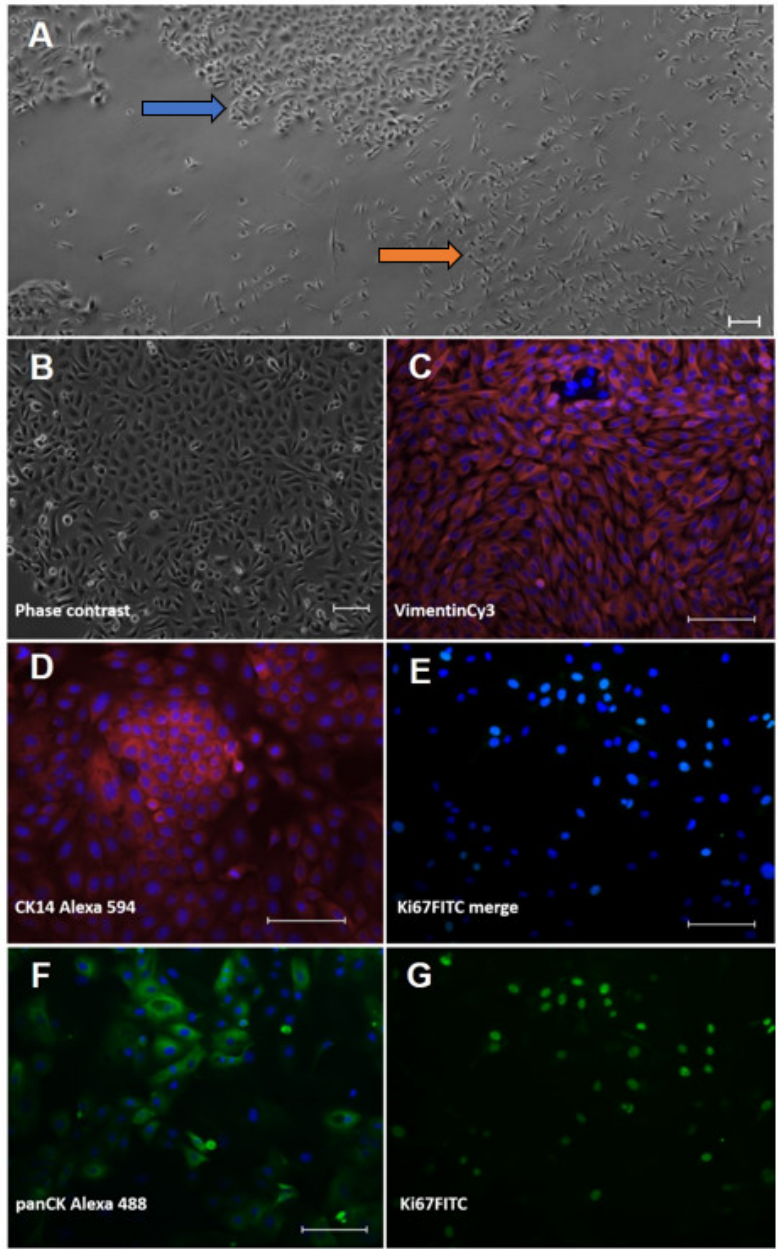
Figure 1. Characterisation of isolated ovine skin cells using immunofluorescence staining. Ker- atinocytes (left column; ( B , D , F )) and fibroblasts (right column; ( C , E , G )) were isolated from ovine interdigital skin and displayed typical cell morphologies in culture. ( A ) primary isolation showing mixed islets of cobblestone-like keratinocytes (blue arrow) and spindle-shaped fibroblasts (orange arrow). ( B ) purified keratinocyte culture. Cell types were stained for typical lineage markers, i.e., ( D ) cytokeratin (CK) 14 and ( F ) pan-cytokeratin in keratinocytes and ( C ) vimentin in fibroblasts, respectively. Proliferation was shown using an antibody directed against the typical proliferation marker, Ki67 ( E ) merged picture and the extracted FITC channel in ( G )). The nuclear counterstain ensued with bisBenzimide Hoechst 33342; all staining was accompanied by a secondary antibody control (omission of first antibody). All scale bars represent 100 μm.